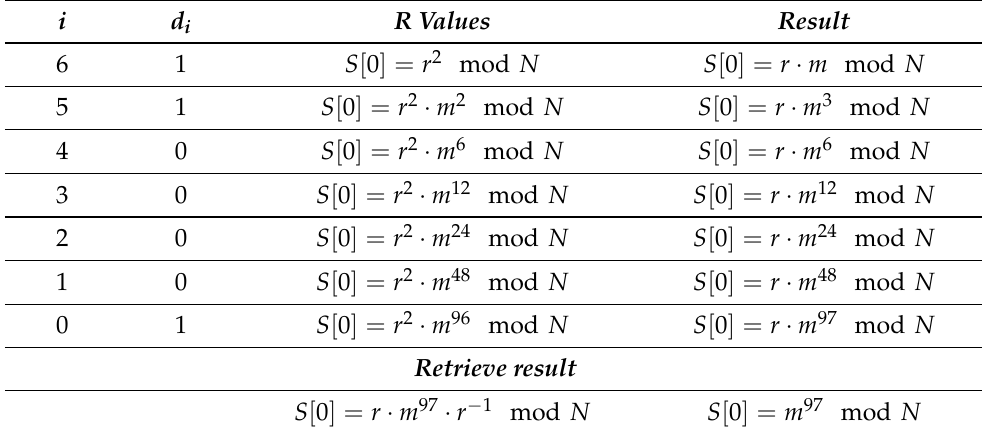
Table 2. Example of the execution of the Algorithm